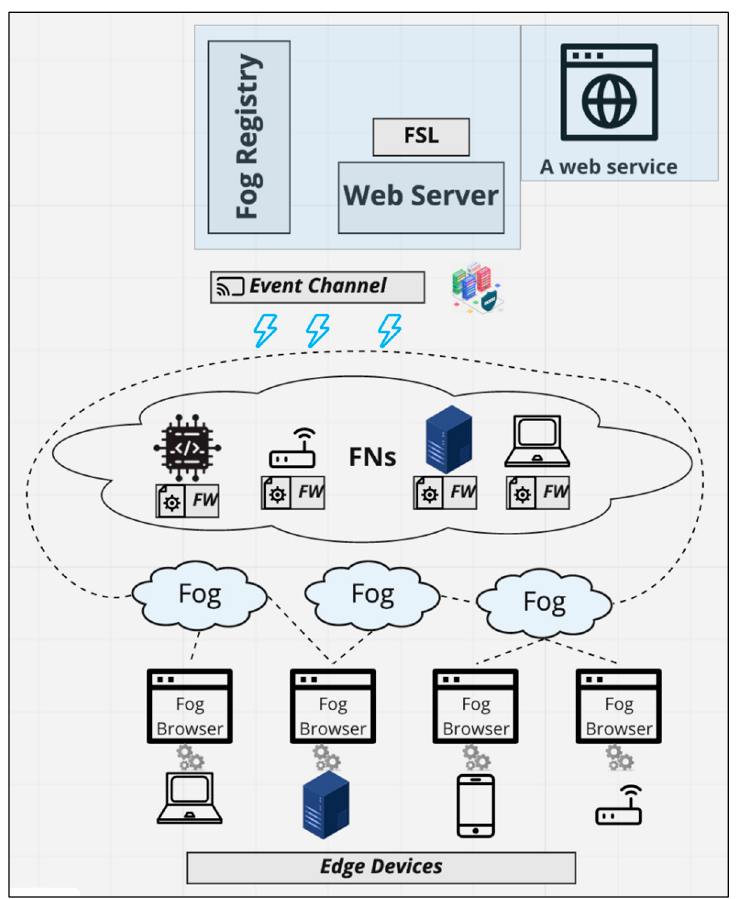
Figure 3. Fog-based CDN architecture and components.